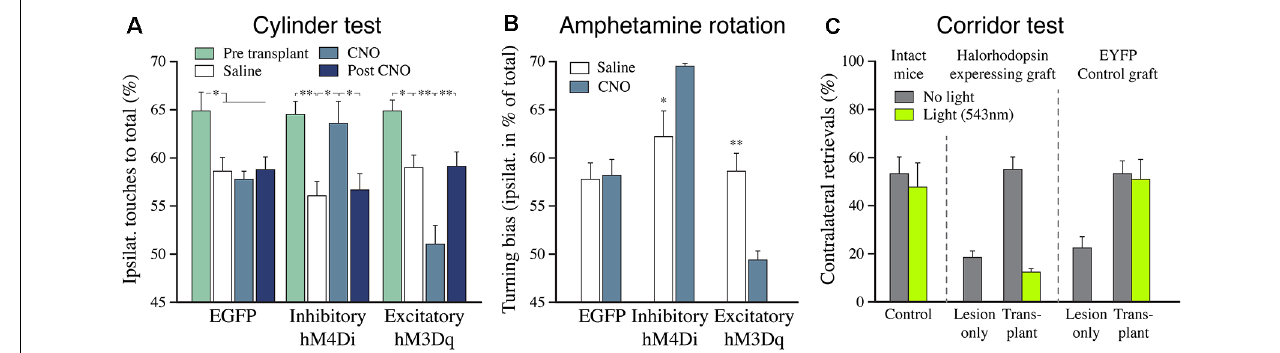
FIGURE 8 | The functional impact of hESC-derived DA neuron grafts is tunable using chemo-and optogenetics. (A) The recovery of paw use in the cylinder test (contralateral to the 6-OHDA lesion) is abolished when the activity of the grafted DA neurons is inhibited by CNO (hM4Di), and it is further potentiated when the activity is increased by CNO (hM3Dq). (B) The effect of inhibition and activation of the grafted human DA neurons is similar in the amphetamine rotation test. The 6-OHDA-induced ipsilateral turning bias is abolished by the grafted DA neurons in all three groups (open bars). Activation of the inhibitory DREADD blocks the graft effect, seen as induction of an ipsilateral turning bias (similar to what is seen in lesioned controls), and activation of the excitatory DREADD potentiates the graft effect, seen as induction of turning in the direction away from the transplant. (C) The graft-induced recovery in sensorimotor performance seen in the corridor test (gray bars) is completely blocked when the activity of the grafted DA neurons is inhibited by light (green bars). Data in panels (A,B) are redrawn from Chen et al. (2016), data in panel (C) redrawn from Steinbeck et al. (2015). ∗ p < 0.05, ∗∗ p <